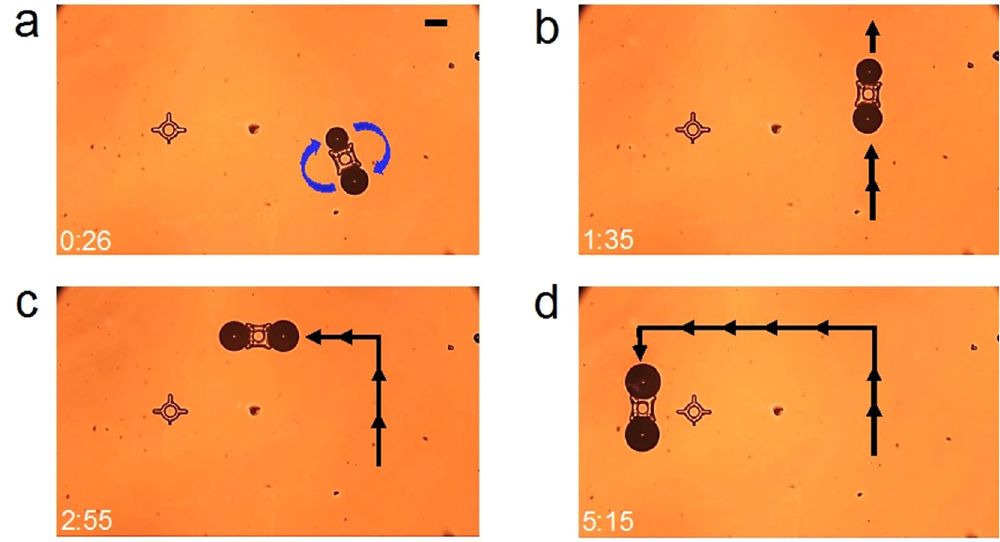
Figure 6. Micromanipulation of a microstructure using a pair of OFB microrobots. ( a ) A pair of OFB microrobots approached an SU-8 structure, grasped it, and rotated it towards the direction of the navigation. ( b–d ) The micro-object was transported along a piecewise linear path. The micro-object was transported along the 2017- µ m-long path at the average speed of 6.0 µ m·s − 1 . Scale bar: 100 µ m. Time format: